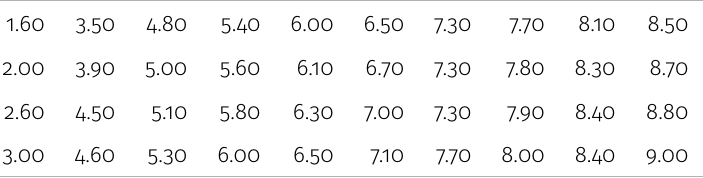
Table A.I. Turbochargers failure time data.